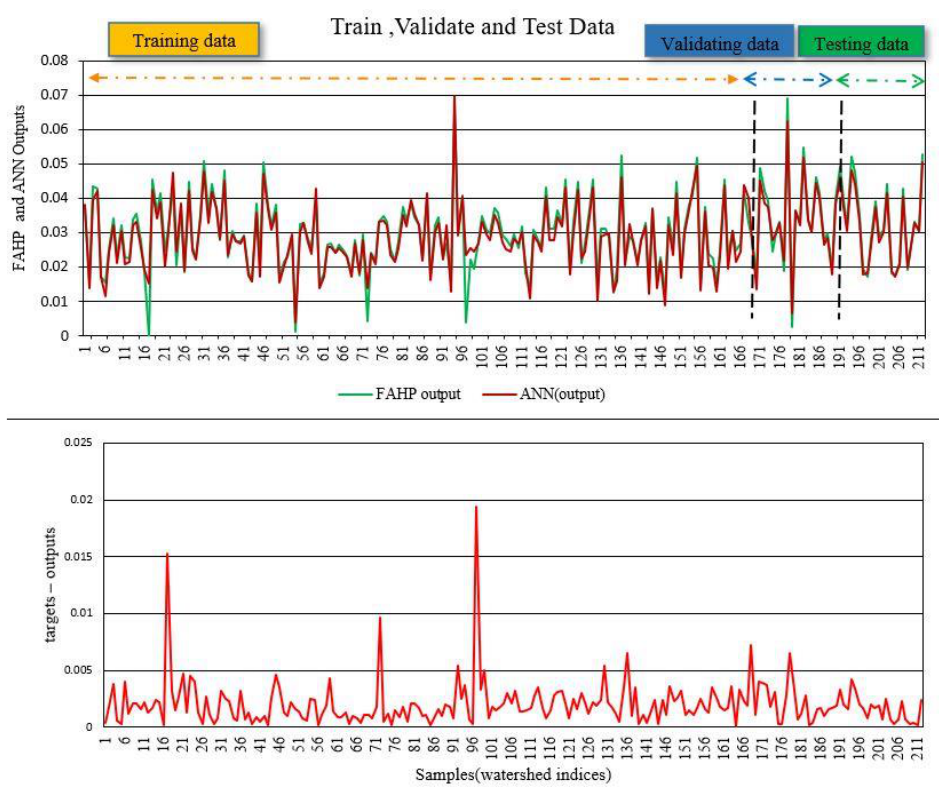
Figure 4. ANN performance for training, validating and testing data.